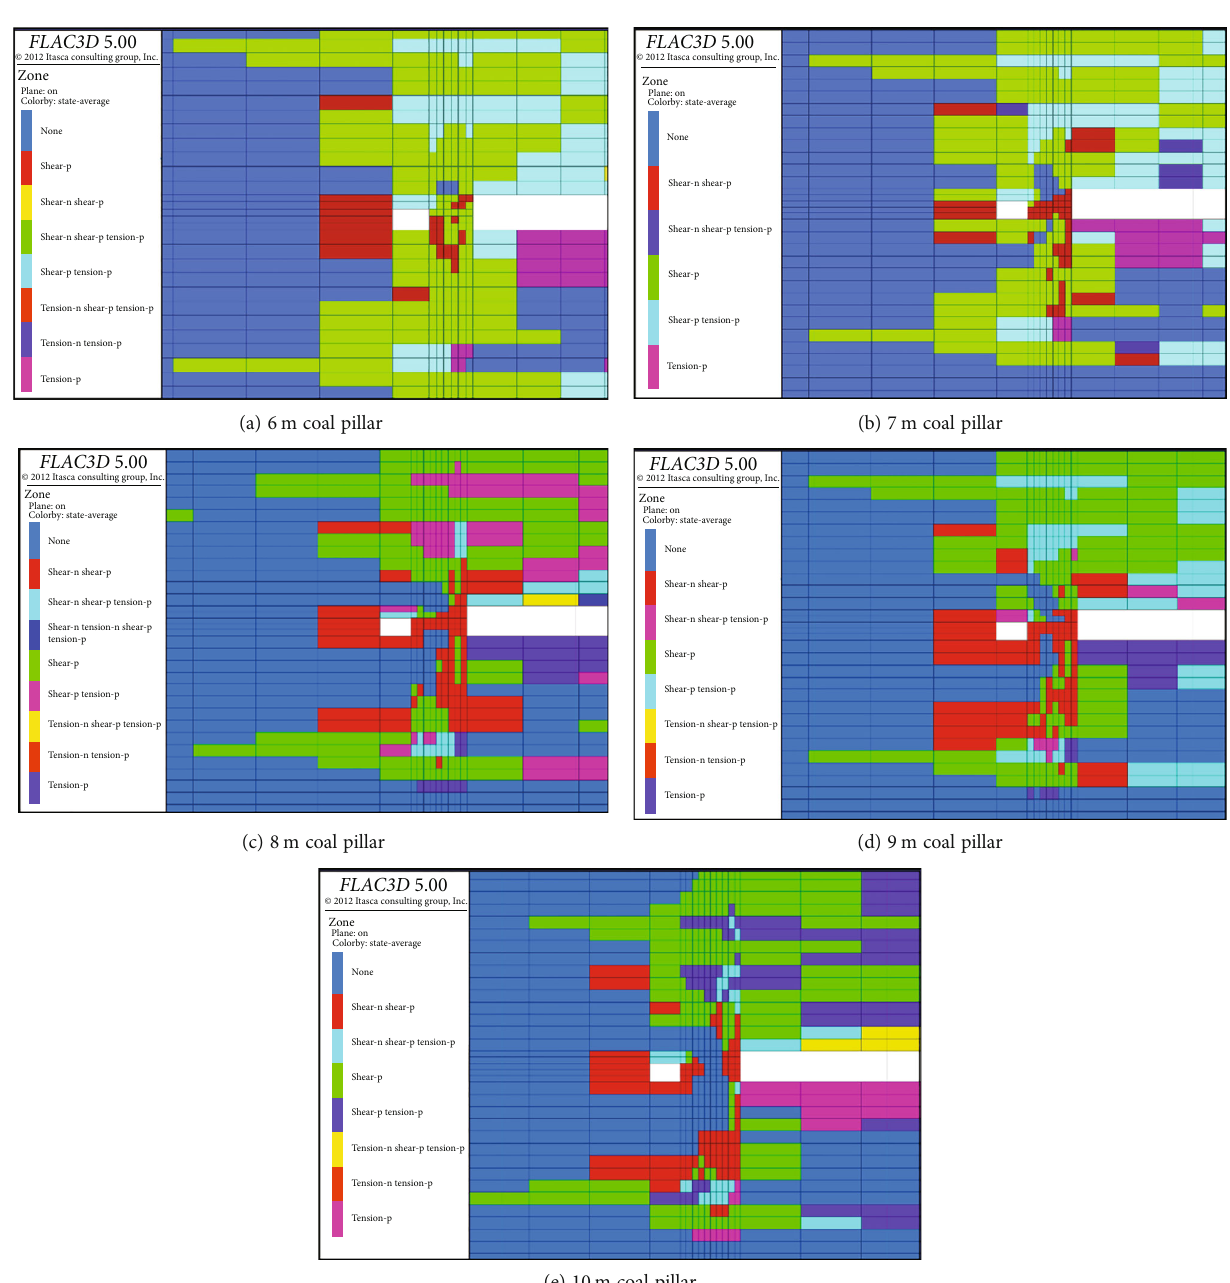
Figure 5: Plastic zone distribution in coal pillars with di ff erent widths and surrounding rock along goaf when the workface was advanced